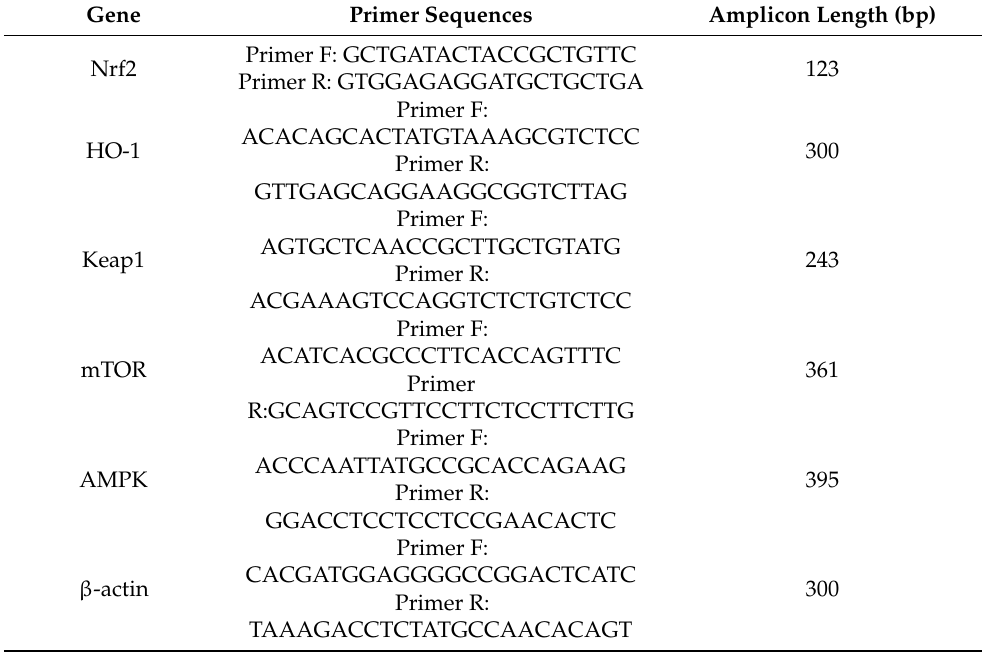
Table 2. The primers used in this